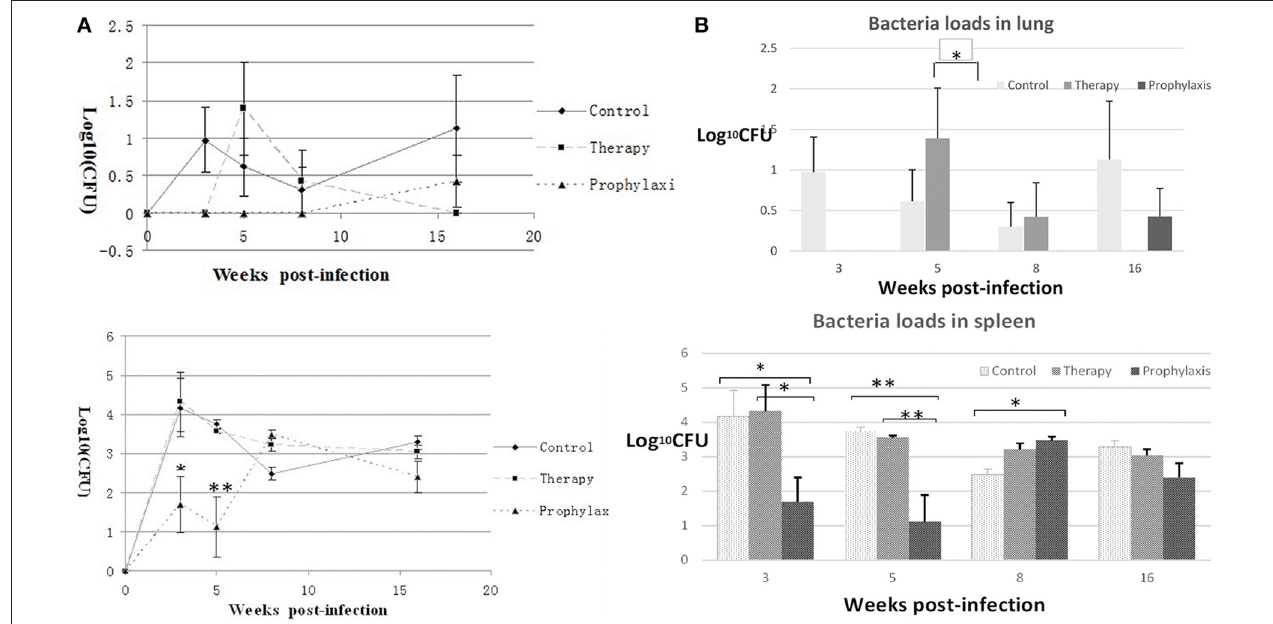
FIGURE 3 | Differences in bacterial loads between the control group and G. lucidum -treated (therapy and prophylaxis) mice. Bacterial loads (log 10 CFU) in the (A) lung and (B) spleen were counted on the L-J medium from week 0 to week 16. One of three similar experiments is shown. The SEMs are plotted as error bars. ANOVA analysis, * P < 0.05 , ** P < 0.01